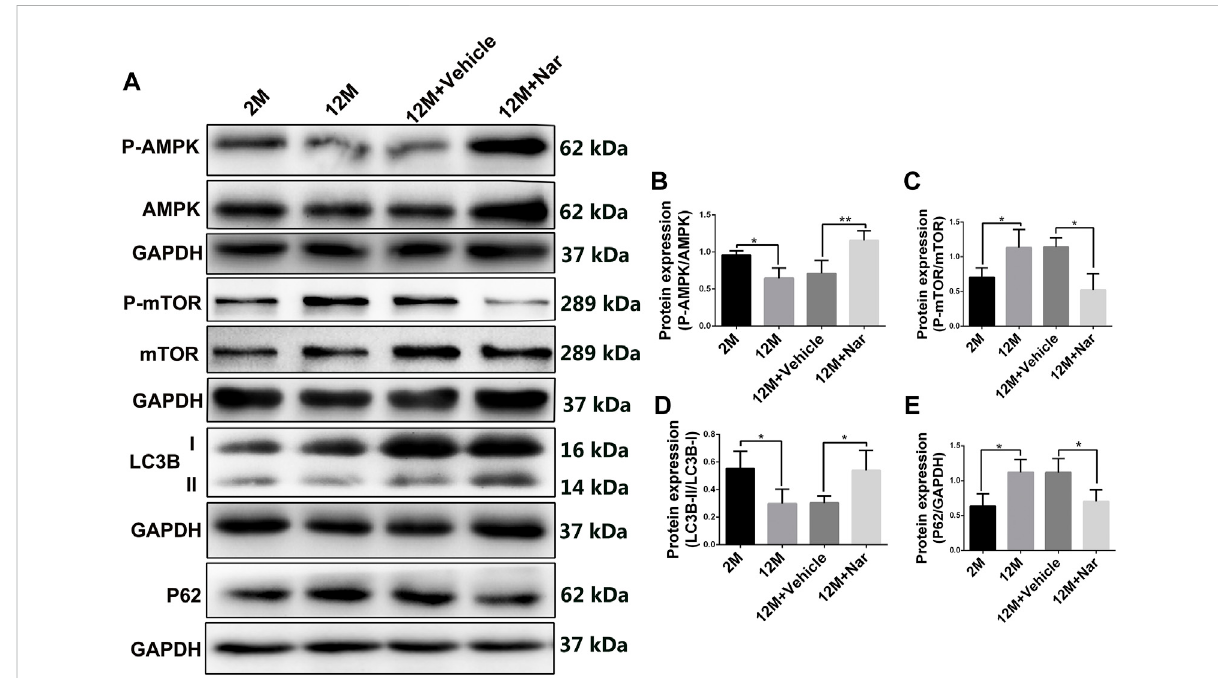
FIGURE 4 Naringenin upregulated autophagy in aging mouse retina via the AMPK/mTOR pathway. (A) Representative western blots of P-AMPK, AMPK, P-mTOR, mTOR, LC3B, and P62. (B) Relative expression levels of P-AMPK/AMPK protein. (C) Relative expression levels of P-mTOR/mTOR protein. (D) Relative expression levels of LC3B-II/I protein. (E) Relative expression levels of P62 protein. The results are expressed as the mean values ± SEM, n = 5. One-way ANOVA, post hoc Tukey ’ s test (* p < 0.05, ** p <